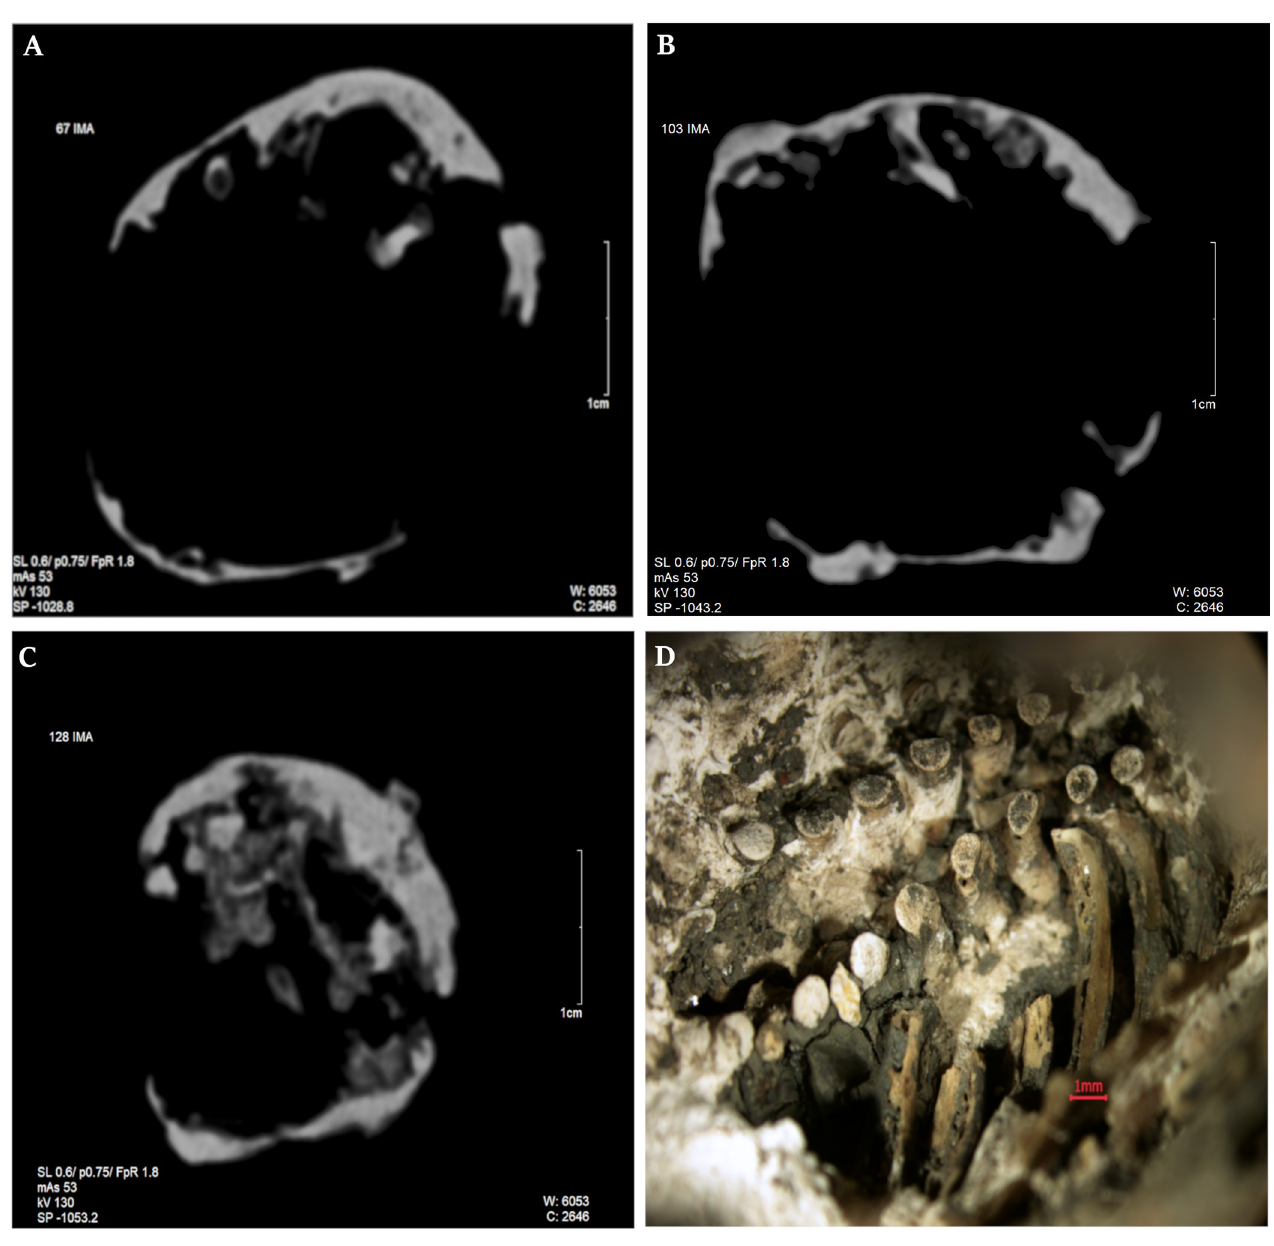
Fig 5. Selected CT layers (A-C; slice no. 67, 103, 128 respectively) and inner view of the cyst